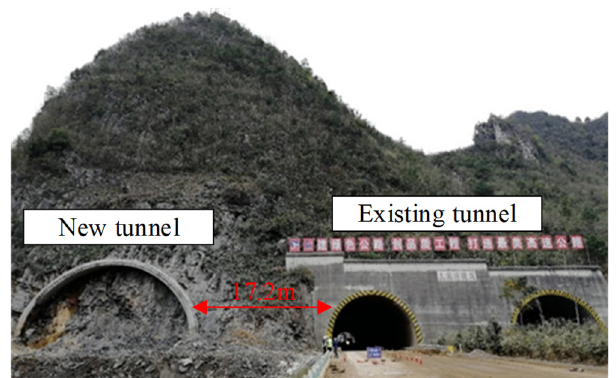
Figure 7. Relative position of the new tunnel to the existing tunnel.